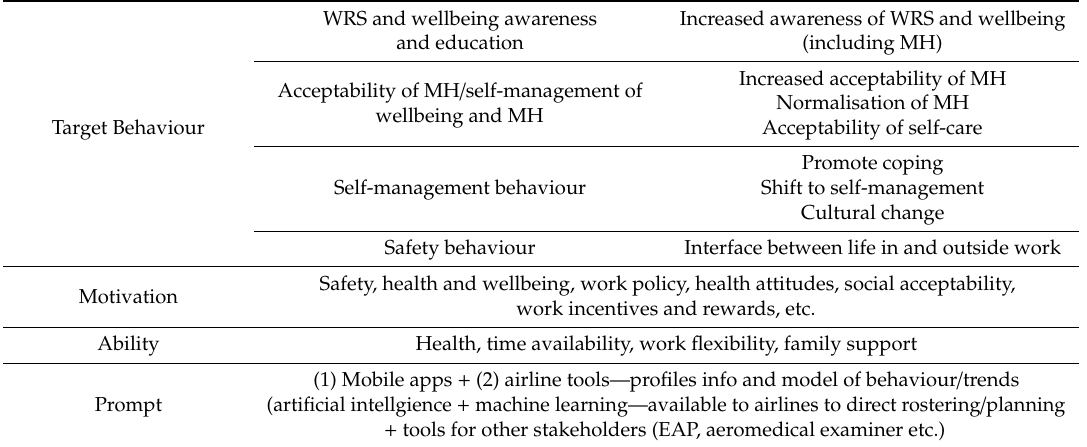
Table 7. Behaviour targets and Fogg model.